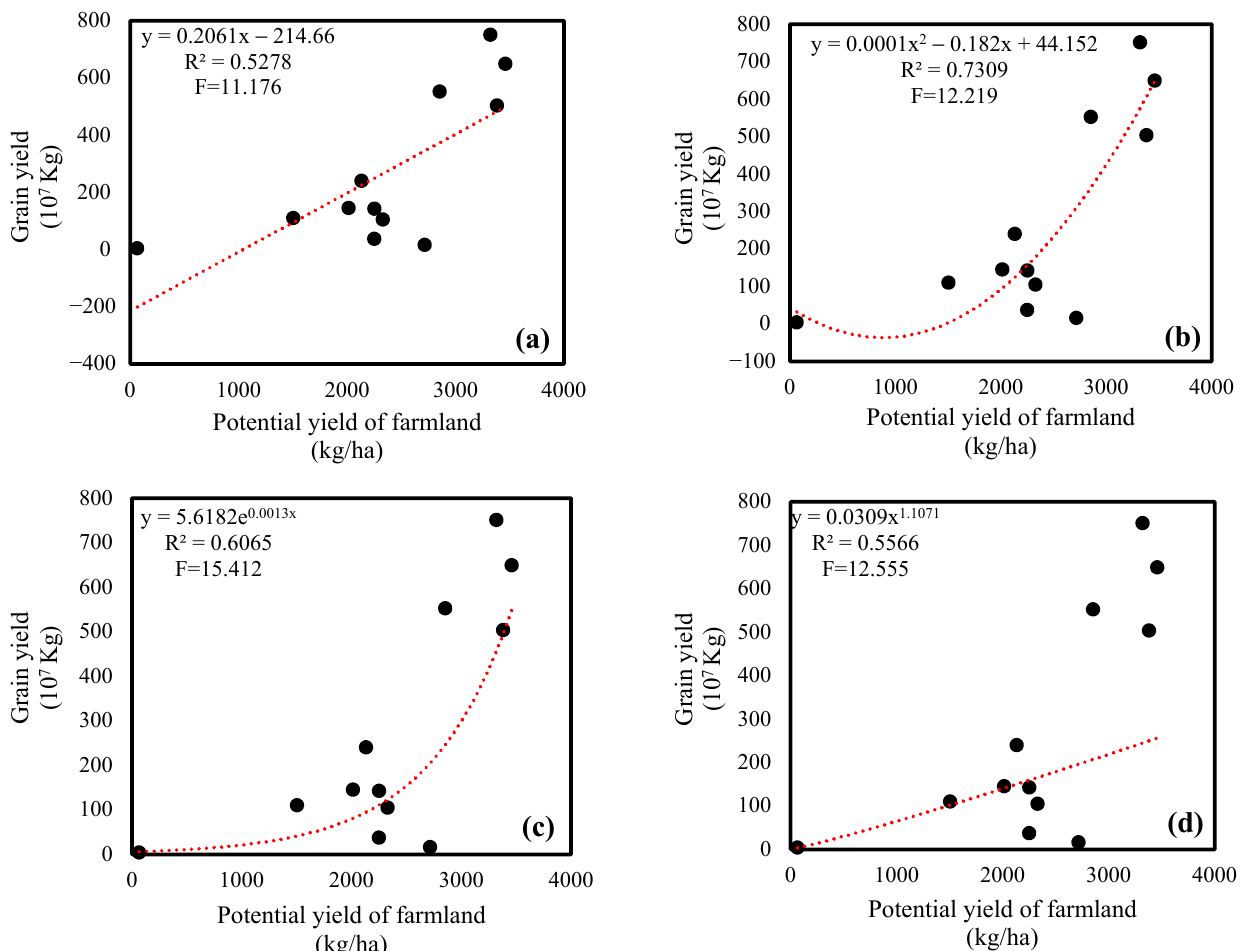
Figure A4. Statistical relationship between potential yield of farmland and grain yield: ( a ) Linear algorithm; ( b ) quadratic polynomial algorithm; ( c ) exponential algorithm; ( d ) power function algorithm.